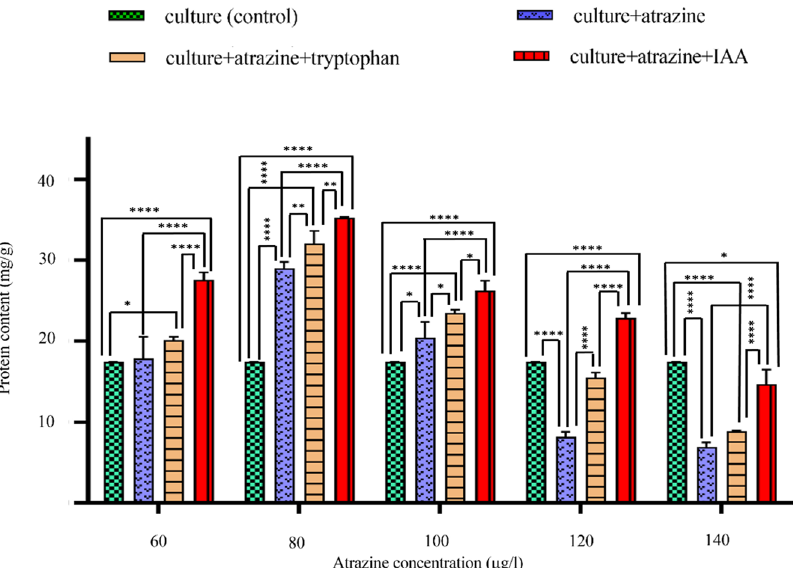
Figure 4. Intergroup and intragroup comparison of mean levels of total protein content on 24th day in C. stagnale , using Two-way ANOVA and Tukey’s multiple comparison test respectively (*p < 0.05; **p < 0.01; ***p < 0.001; ****p < 0.0001). All the values were found to be statistically significant. Two-way ANOVA analysis and Tukey’s multiple comparison test showed that all the values were statistically significant at all concentrations of atrazine and it can be deduced that all the four treatments (control, atrazine, atrazine + l-tryptophan, and atrazine + IAA) had a well-defined effect on the total protein content of the strain through the various concentrations of atrazine.